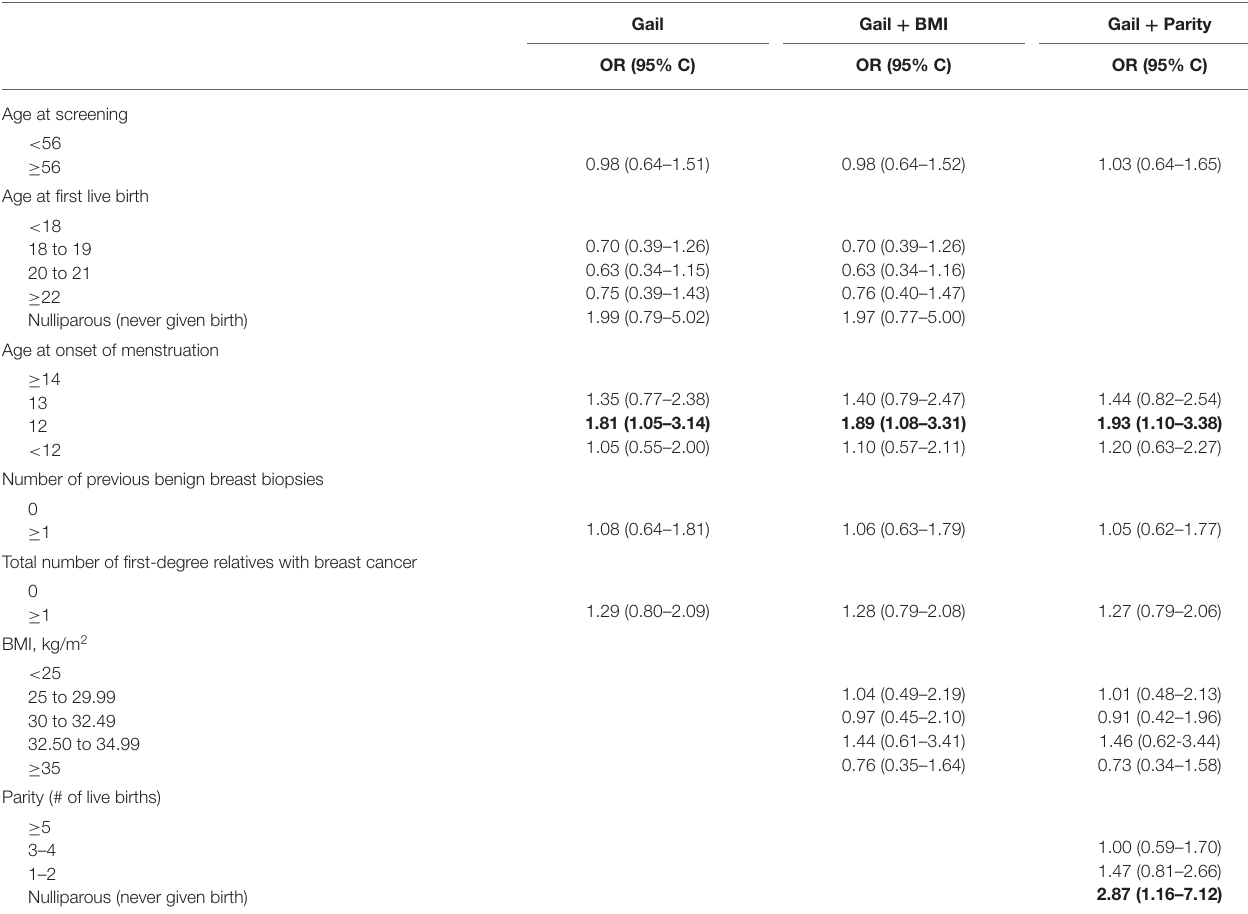
TABLE 2 | Logistic regressions using risk factors from gail model with adjusted categories.